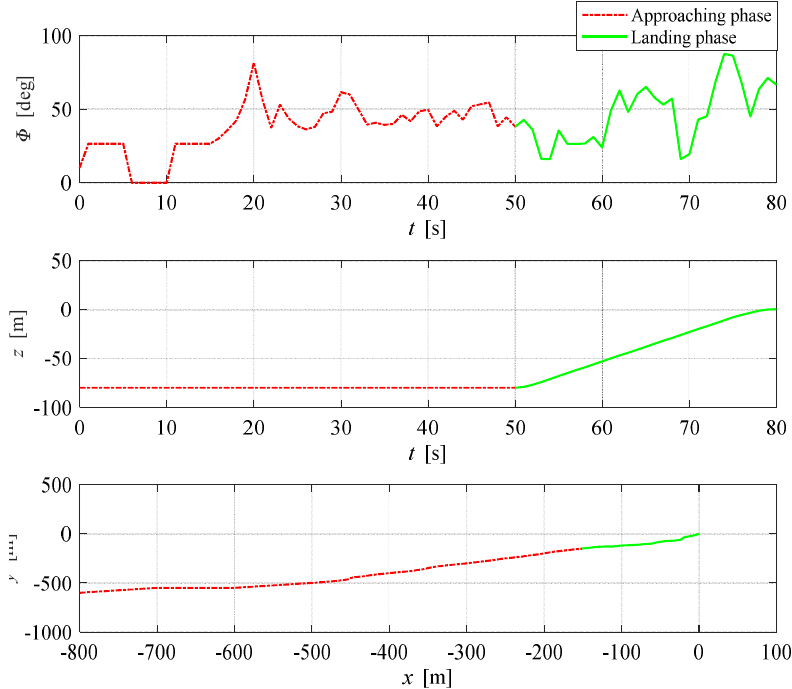
Figure 6. State of the helicopter during the landing task.